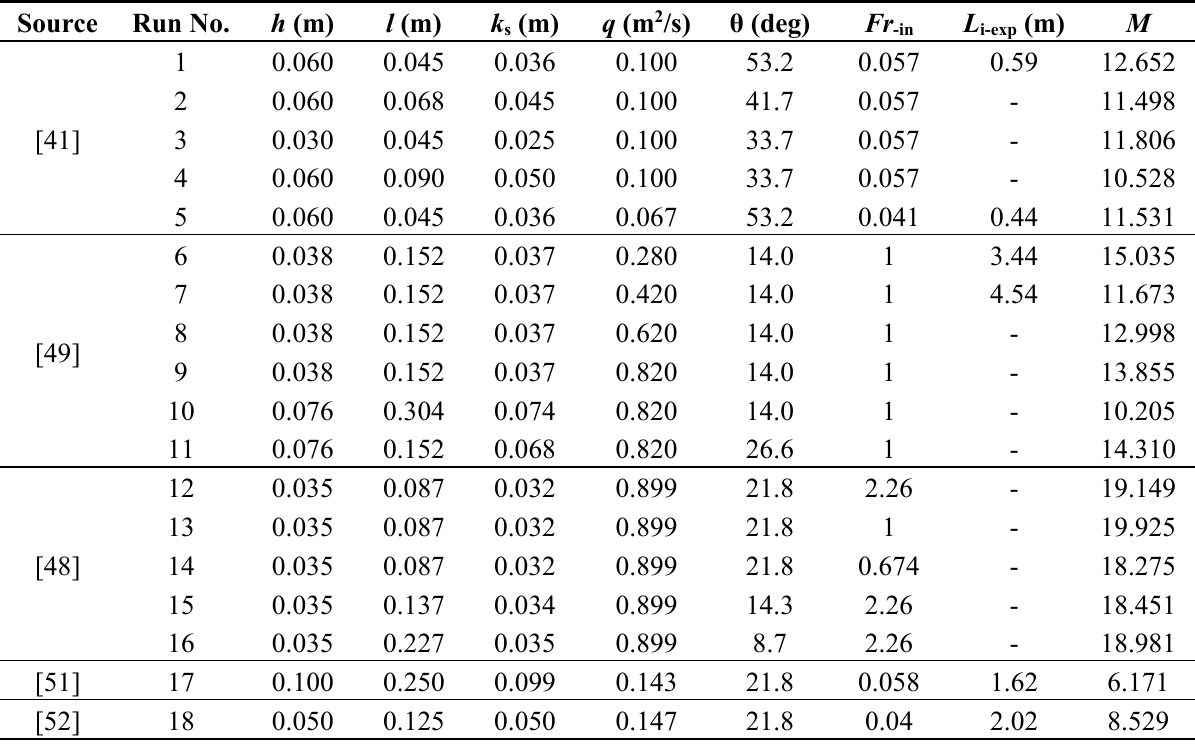
Table 2. Conditions of each numerical